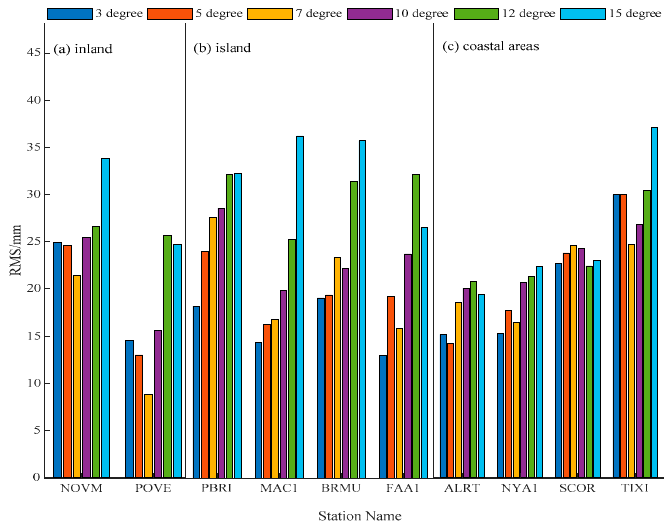
Figure 13. The RMS differences between the GNSS-derived ZTD and the radiosonde-derived ZTD at 10 stations with six cutoff elevations using the FES2004 model at ( a ) inland, ( b ) island, and ( c ) coastal areas.